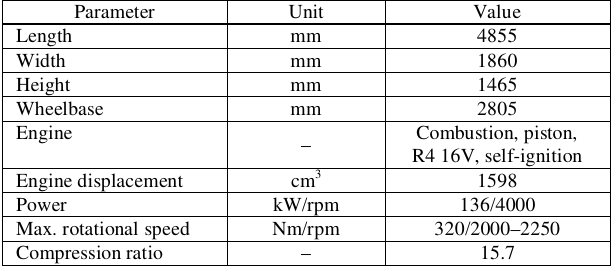
Table 6. Chosen technical parameters of the vehicle used in the tests